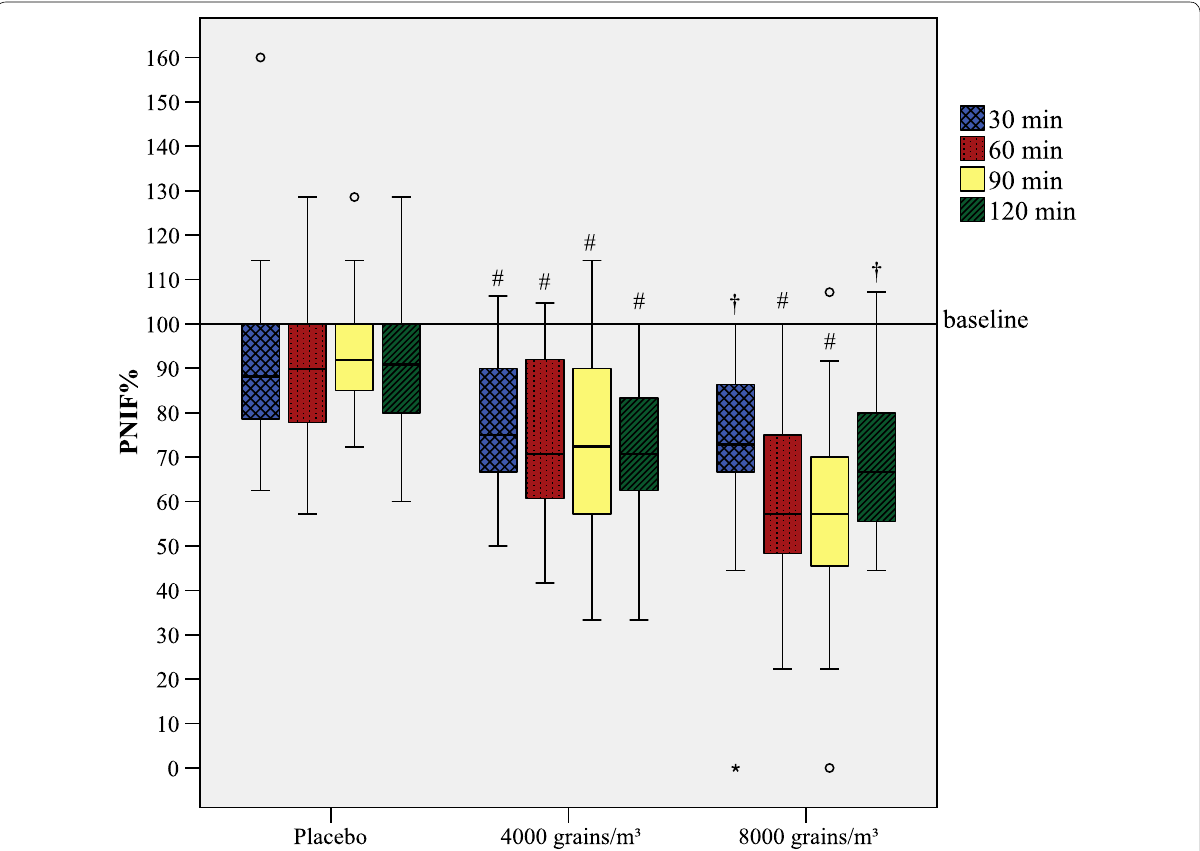
Fig. 1 Reduction of PNIF during exposure with grass pollen in the GA 2 LEN chamber. PNIF development during exposure with Phleum pratense . A hash marks a reduction compared to baseline p < 0.001, a dagger a reduction compared to baseline p < 0.01. Outliers are presented as degree sign, extreme outliers as asterisk. PNIF% from both actively exposed groups (4000 and 8000 grains/m 3 ) is significantly lower (p < 0.05) than in the placebo group at every associated time of measurement. PNIF% is displayed as medians and